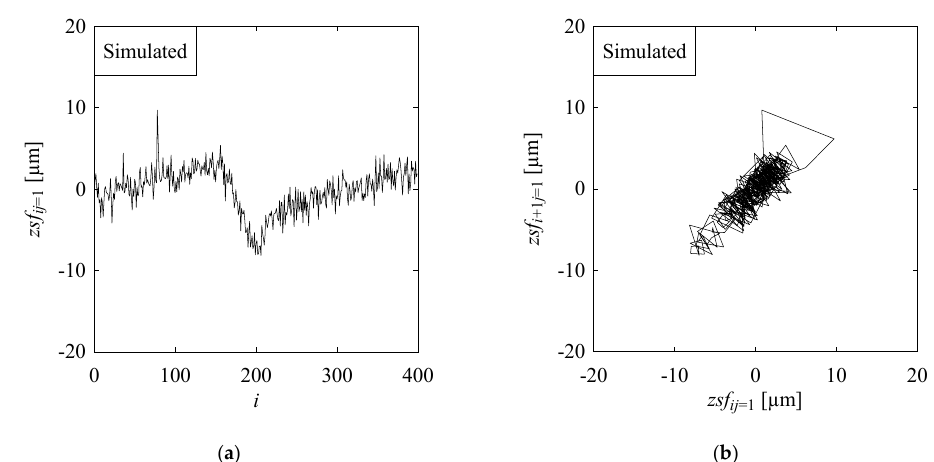
Figure 11. Outcomes of the Monte Carlo simulation-based SC associated with the semantic modeling-based MC: ( a ) simulated surface heights; ( b ) return map of ( a ).